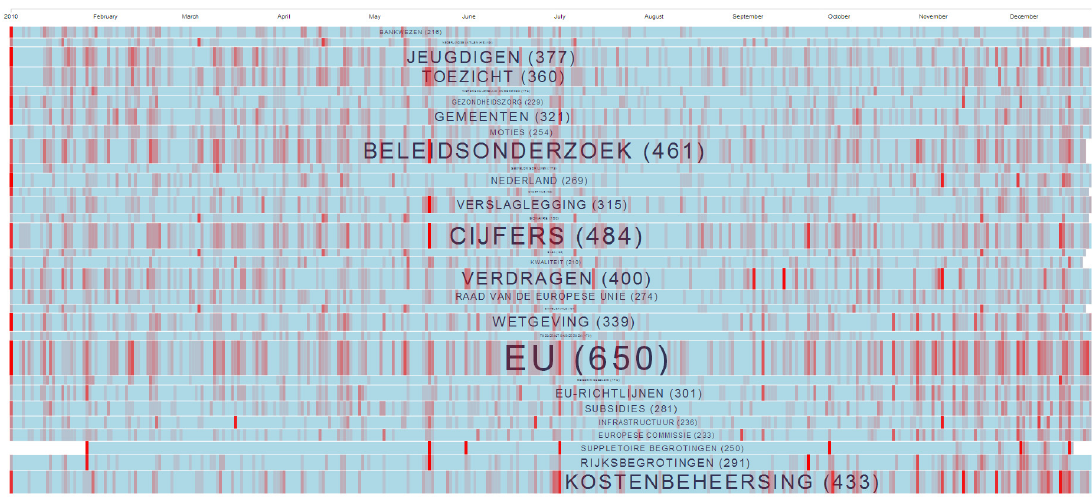
Figure 6. Cost control (Kostenbeheersing) has been an active topic in 2010.